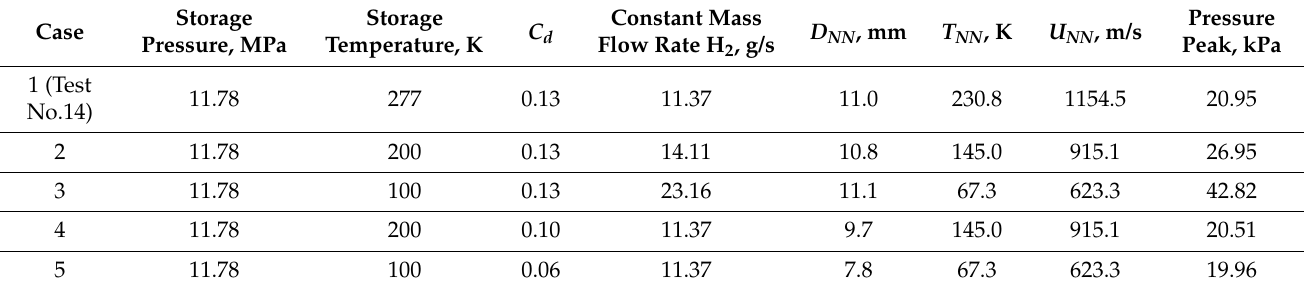
Table 4. Simulations to assess effect of storage temperature on PPP: storage, release and notional nozzle conditions.